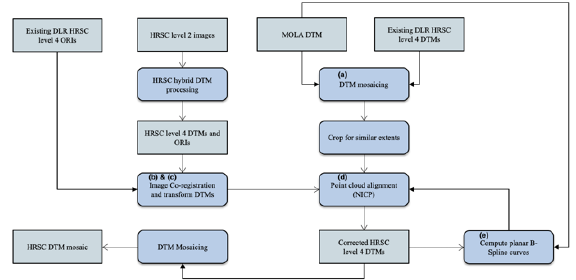
Figure 1. Flow diagram of the joint 3D and image co-registration processing chain for HRSC-to-HRSC and HRSC-to-MOLA co- alignment. See [3] for details of each individual component.